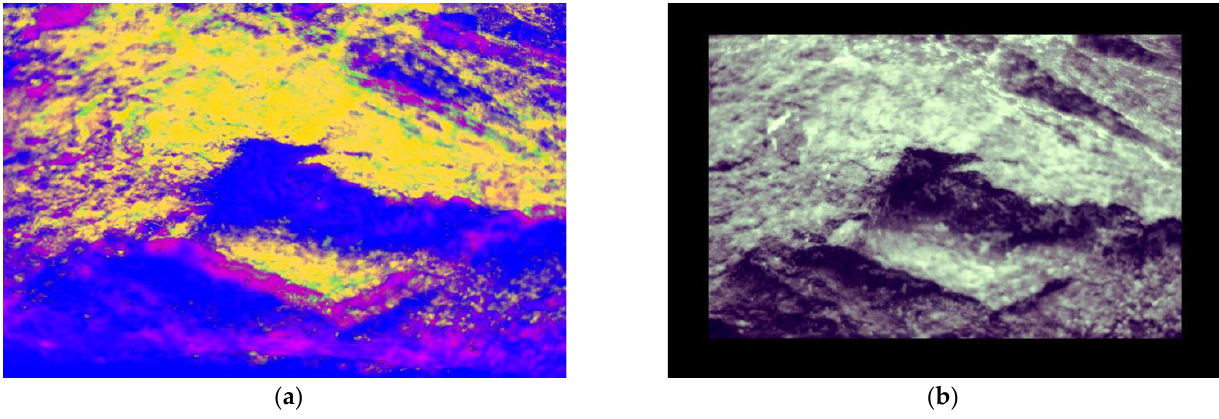
Figure 10. The arithmetic mean of the images of Figure 10: before registration ( a ), after registration ( b ). The software used has been written by the author. Taken from [26].